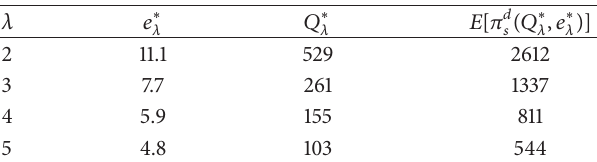
Table 4: Effect of 𝜆 on the optimal policies of the decentralized system.